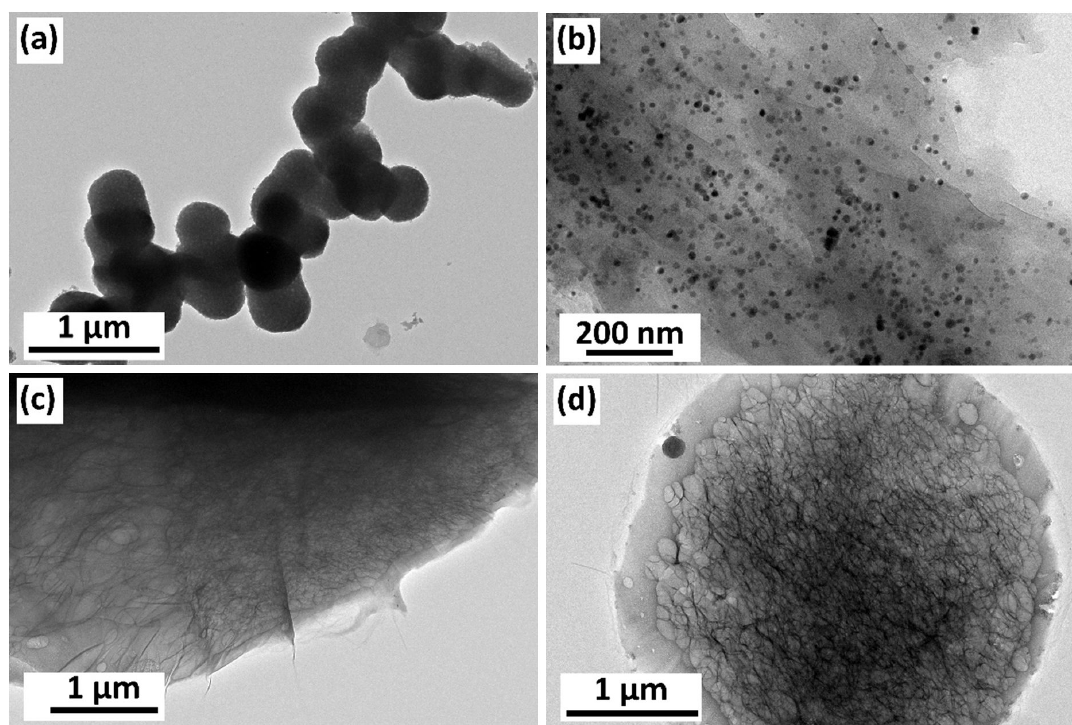
Figure 5. TEM images of (a) amorphous silica produced through sodium silicate neutralized with acetic acid and (b-d) dry PMF-Si composite.